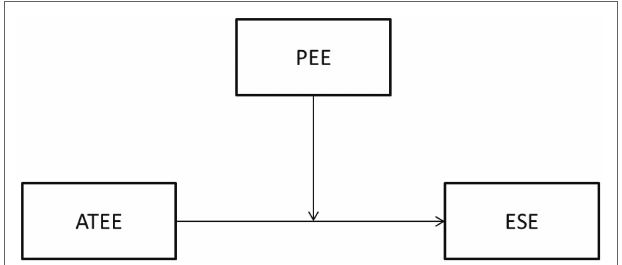
FIGURE 1 | Research framework. ATEE means attitudes toward entrepreneurship education; PEE means post-pandemic entrepreneurial environment; ESE means entrepreneurial